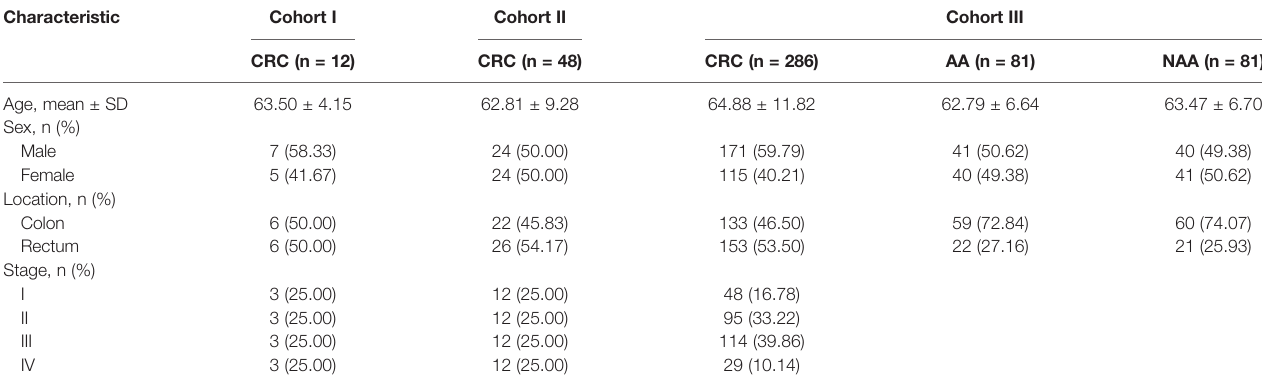
TABLE 1 | Basic characteristics of the study participants.